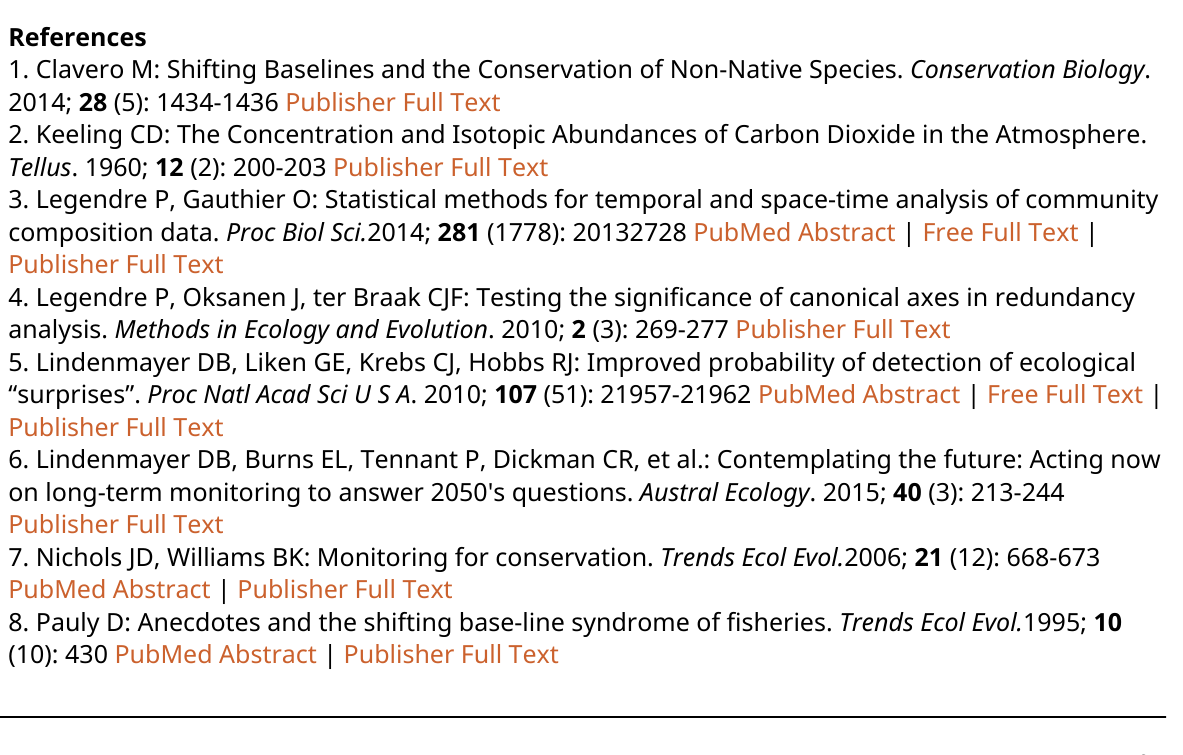
Table 2, p. 5: for counts with skewed distributions, the standard deviation (SD) might be a poor descriptor of the variability (the mean might also be a poor descriptor of location). It might be useful to give the range and median in addition to mean and SD. Table 3: what is meant by “results”? Correlations? How are P-values